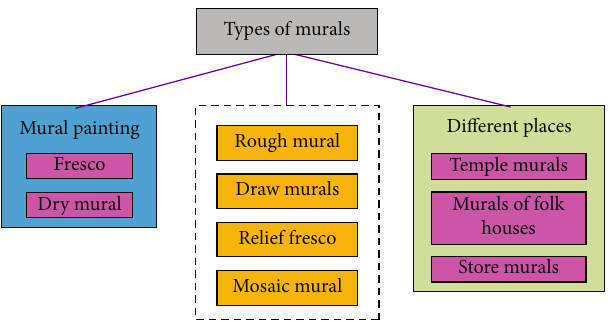
Figure 1: The types of